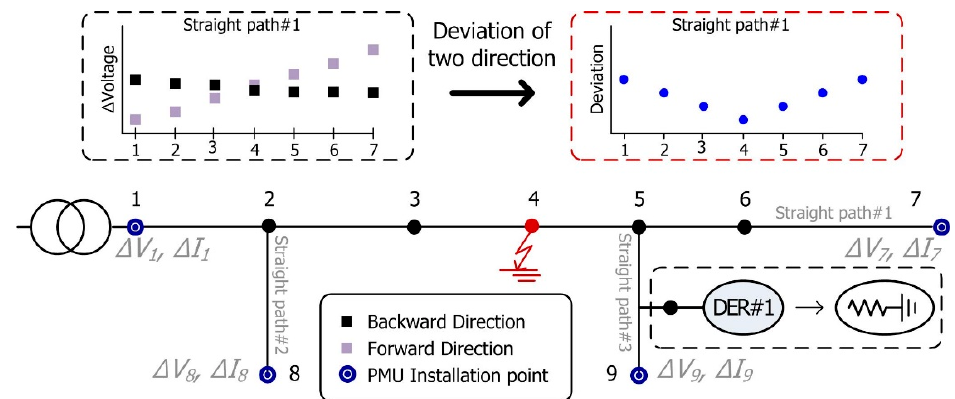
Figure 2. Outline of the PMU-based fault location method [12].